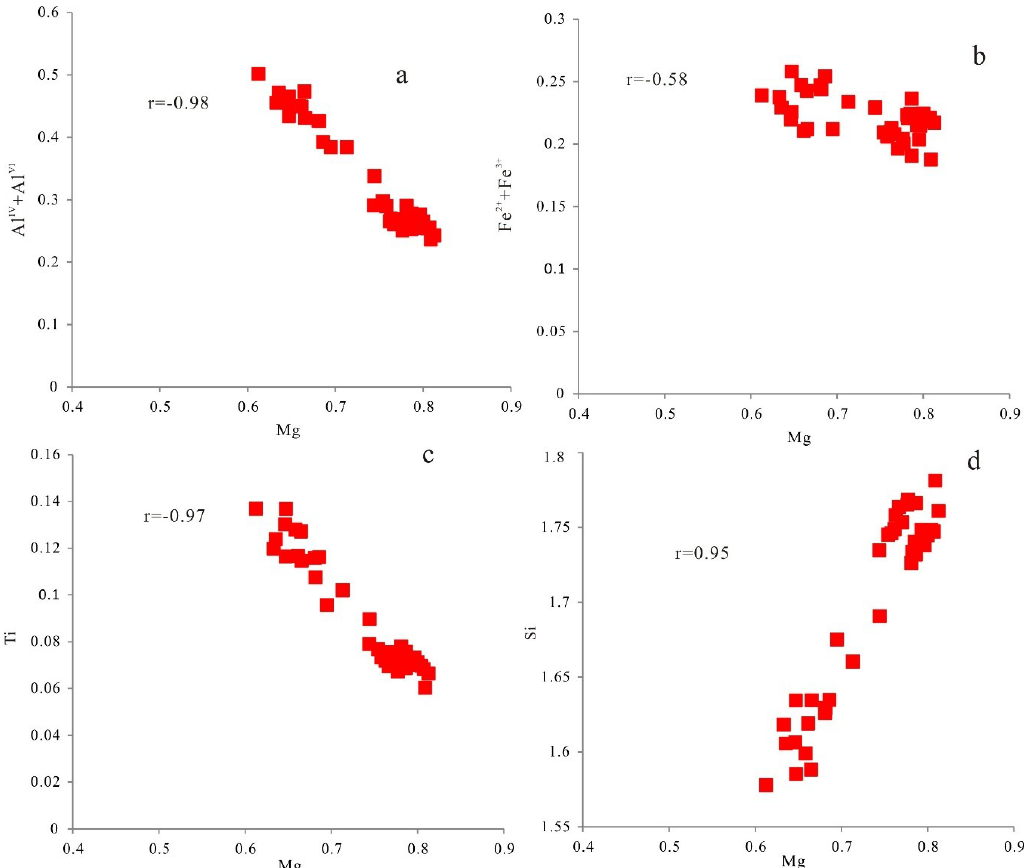
Figure 4. Plots of Mg contents vs. concentrations of other cations in clinopyroxenes. (a) Al IV + Al VI vs Mg; (b) Fe 2+ + Fe 3+ vs Mg; (c) Ti vs Mg; d: Si vs Mg